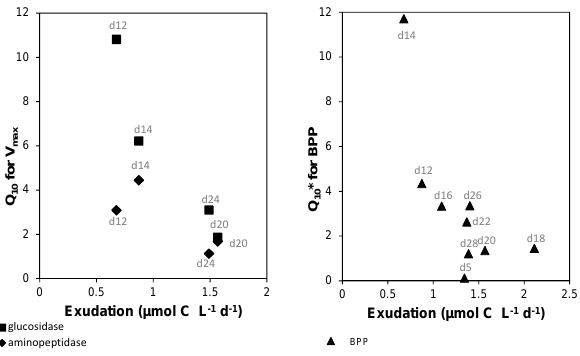
Fig. 9. Q 10 values for extracellular enzyme activities ( β - glucosidase, leu-aminopeptidase) and Q 10 * values for bacterial protein production (BPP) in relation to phytoplankton exudation at different sampling days (e.g., d14: day 14 of the